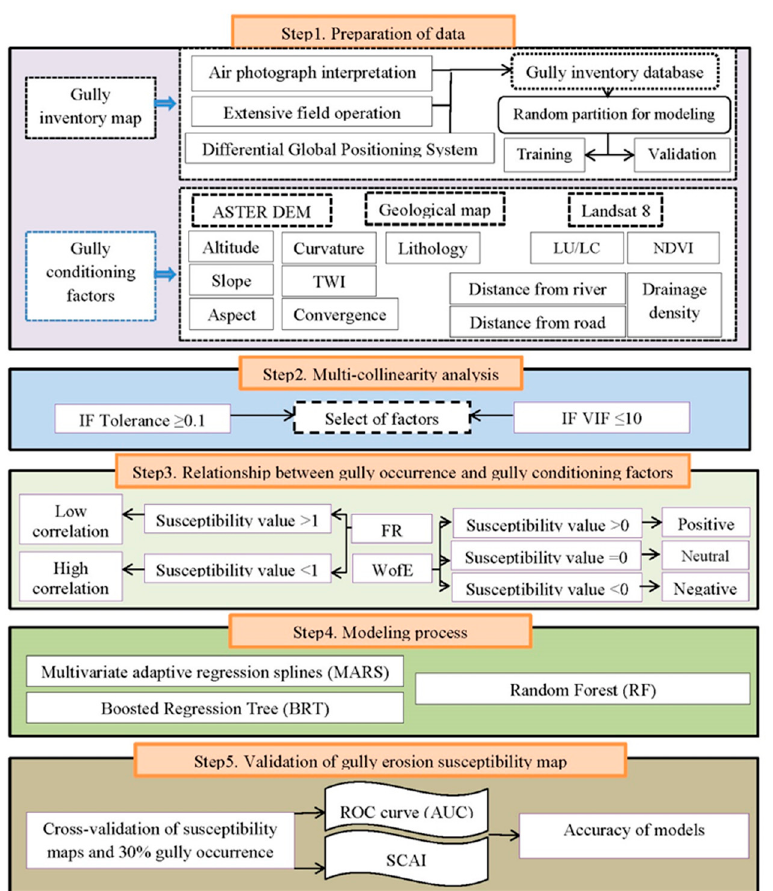
Figure 2. Flowchart of research methodology.